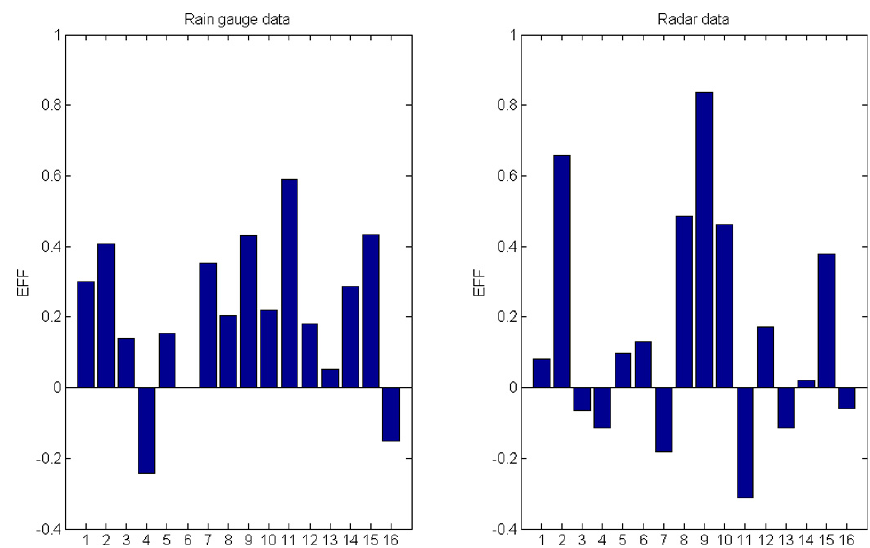
Fig. 10. EFF index between uniform or spatially distributed rainfall data with rain gauge data (left) and radar data